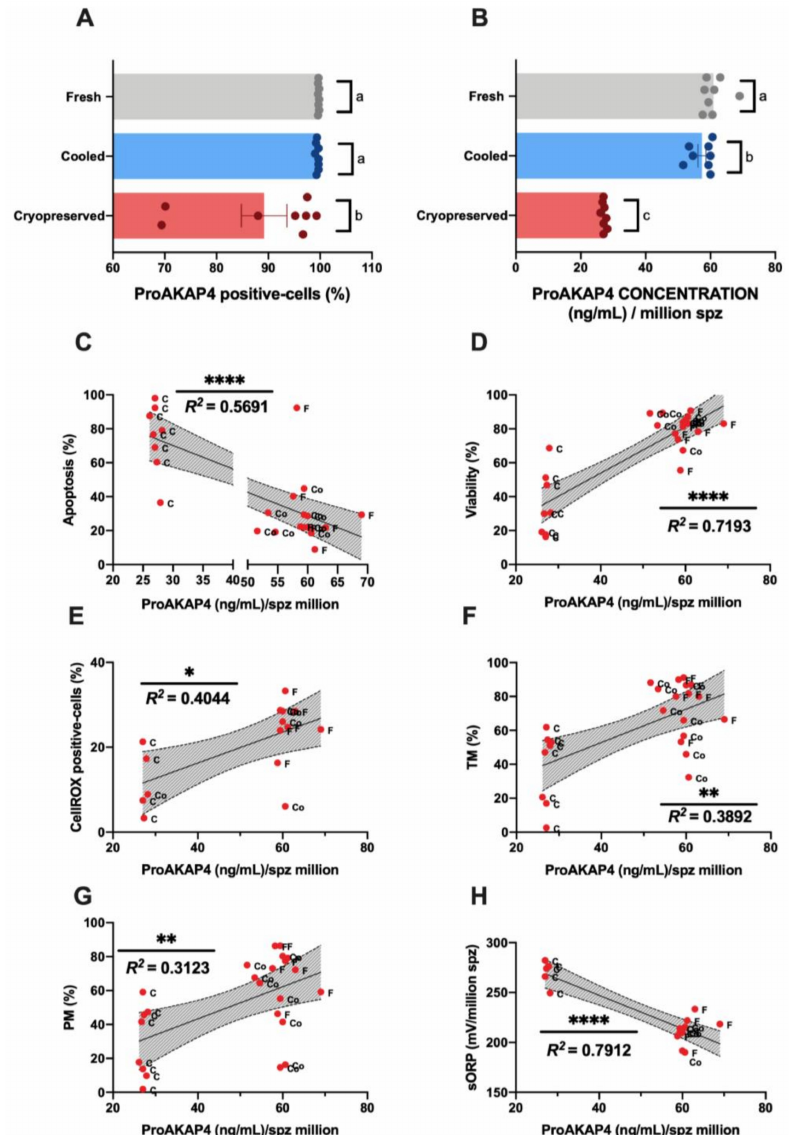
Figure 4. Ram sperm ProAKAP4 analyses in the three experimental groups (fresh, cooled, and cryopreserved samples). ( A ) ProAKAP4-positive sperm population by flow cytometry (%); ( B ) ProAKAP4 concentration (ng / mL) in each experimental group; ( C ) correlation between ProAKAP4 concentration (ng / mL) and apoptosis (%); ( D ) correlation between ProAKAP4 concentration (ng / mL) and viability (%); ( E ) correlation between ProAKAP4 concentration (ng / mL) and CellROX-positive cells (%); ( F ) correlation between ProAKAP4 concentration (ng / mL) and total motility (TM, %); ( G ) correlation between ProAKAP4 concentration (ng / mL) and progressive motility (PM, %); ( H ) correlation between ProAKAP4 concentration (ng / mL) and sORP (mV / 10 6 sperm). The same eight males were analyzed in each experimental group. In ProAKAP4 sperm analysis, significant di ff erences ( p < 0.05) are represented with di ff erent letters. In correlation studies, the R squared value is included in each graph, a significant correlation as represented by a di ff erent number of asterisks. The number of asterisks (*) indicates the significance levels: one asterisk (*) indicates p < 0.05, two asterisks (**) indicate p < 0.01 and four asterisks (****) indicate p < 0.0001. Non-significant correlations are included in the correlation matrix (Appendix A, Figure